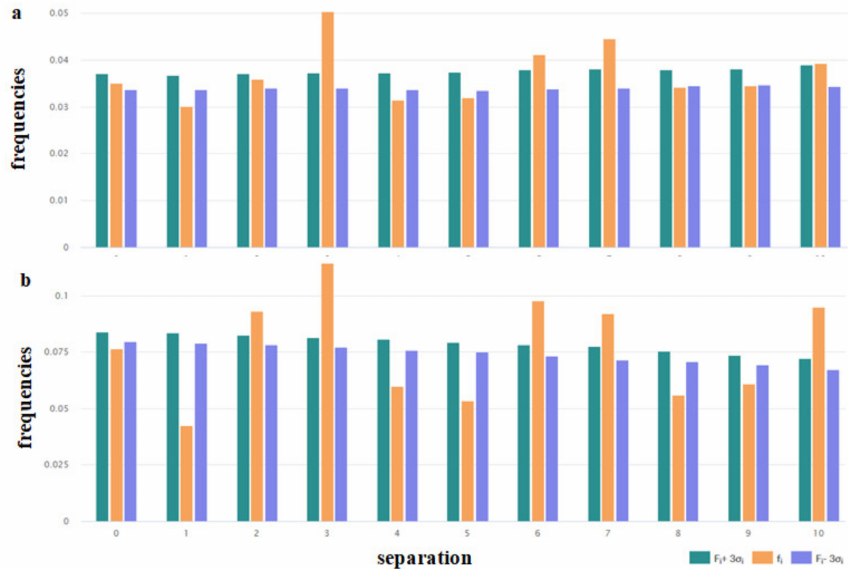
Figure 3. Frequencies of the appearance of pairs of ( a ) positively charged residues (R, K, H) and ( b ) hydrophobic residues (V, I, L, F, M) with the i residues ( i = 0, 1, 2, . . . , 10) between them. fi- Observed frequencies; Fi- the average value of the frequencies assessed on the base of random sequences, and σ i are their standard deviations. Fi frequencies are estimated for random sequences generated by shuffling of the sequences of the considered set of peptides. The assessments were performed using the tools of the page of “Statistics” (https://dbaasp.org/statistics, accessed on 20 March 2021) of the DBAASP